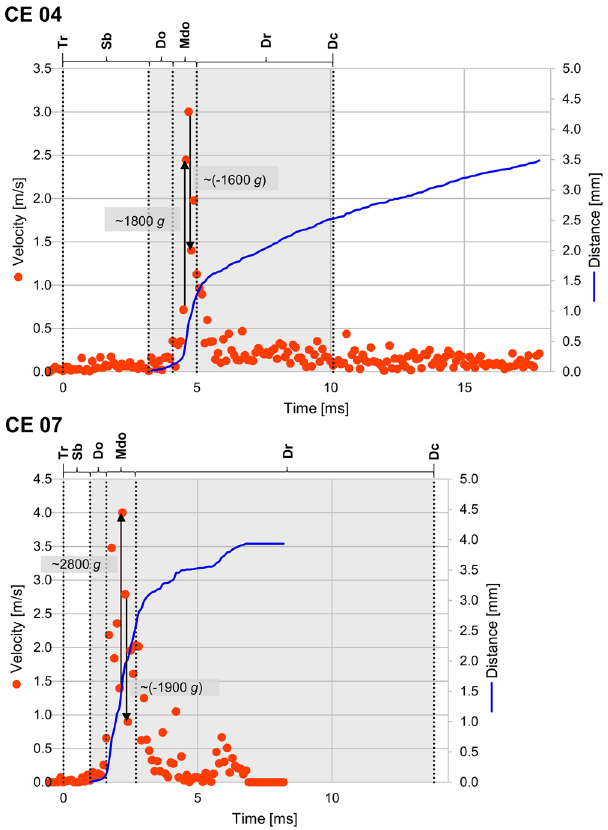
Figure 3. Interrelations of prey and trap movement steps and phases, exemplarily depicted for CE 04 and CE 07. Velocity of captured prey animals (red dots) and distance travelled by captured prey animals (solid blue line) are depicted over time, with maximum acceleration g max and maximal deceleration g min indicated by black arrows. On the upper margins of the graphs, the trap movement steps/phases are indicated: trap triggering (Tr), snap-buckling of the trapdoor (Sb), door opening (Do), phase of maximum door opening (Mdo), door re- closure (Dr), and the point in time when door is fully closed again (Dc). The phases in which suction took place are grayed out. The interrelations for the other CEs can be seen in Figures